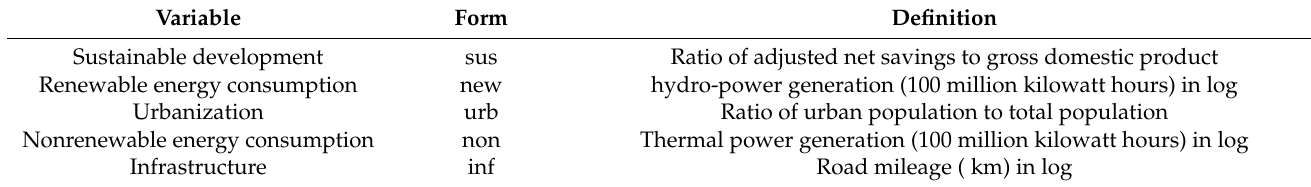
Table 1. Variable